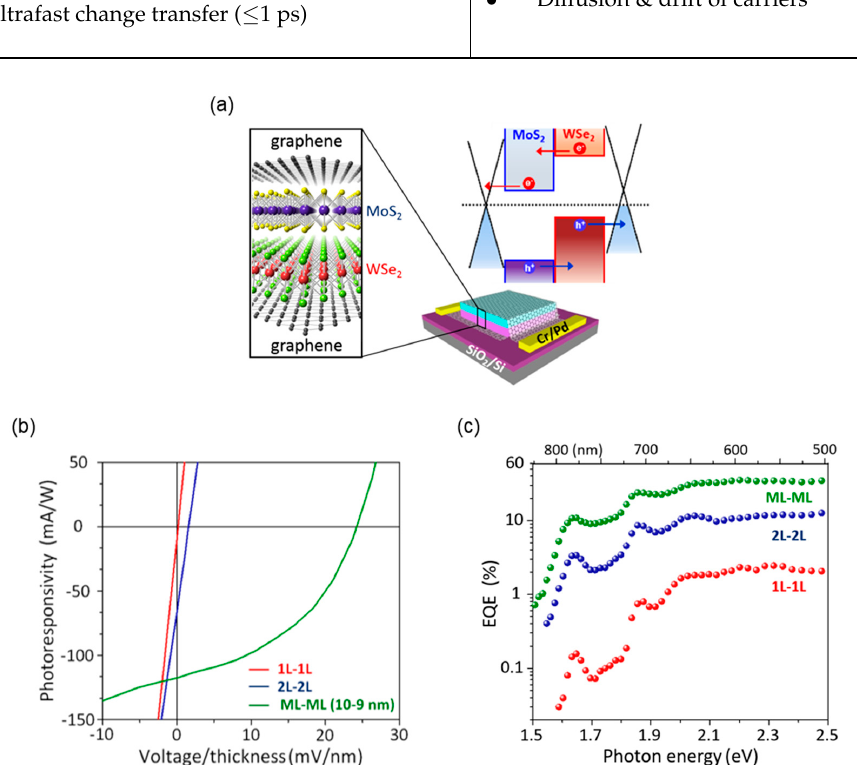
Figure 7. Photodetection and/or photovoltaic devices based on the 2D semiconductor heterostructure consisting of graphene/TMDC p ‐ n junction/graphene: ( a ) schematic illustration of the atomic crystal structure, band alignment, and device geometry; ( b ) photoresponse characteristics; and ( c ) the measured external quantum efficiency (EQE) as a function of excitation wavelength for the devices with different thicknesses of the p ‐ n junctions. Reproduced with permission from [99]. Copyright Nature, 2014.